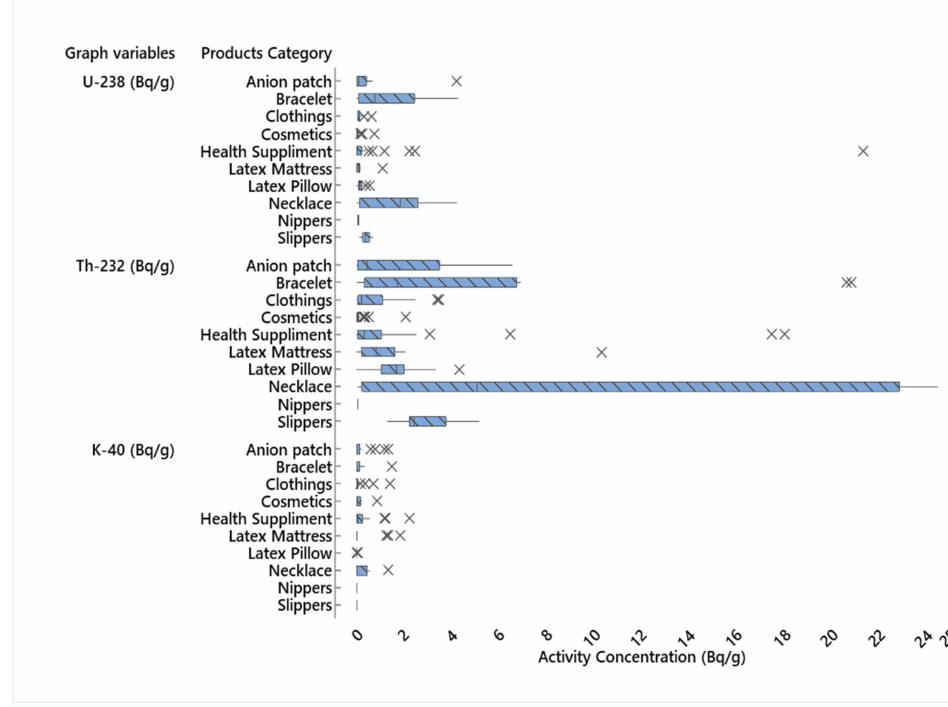
Figure 1. Statistical Analysis of 238 U, 232 Th and 40 K using